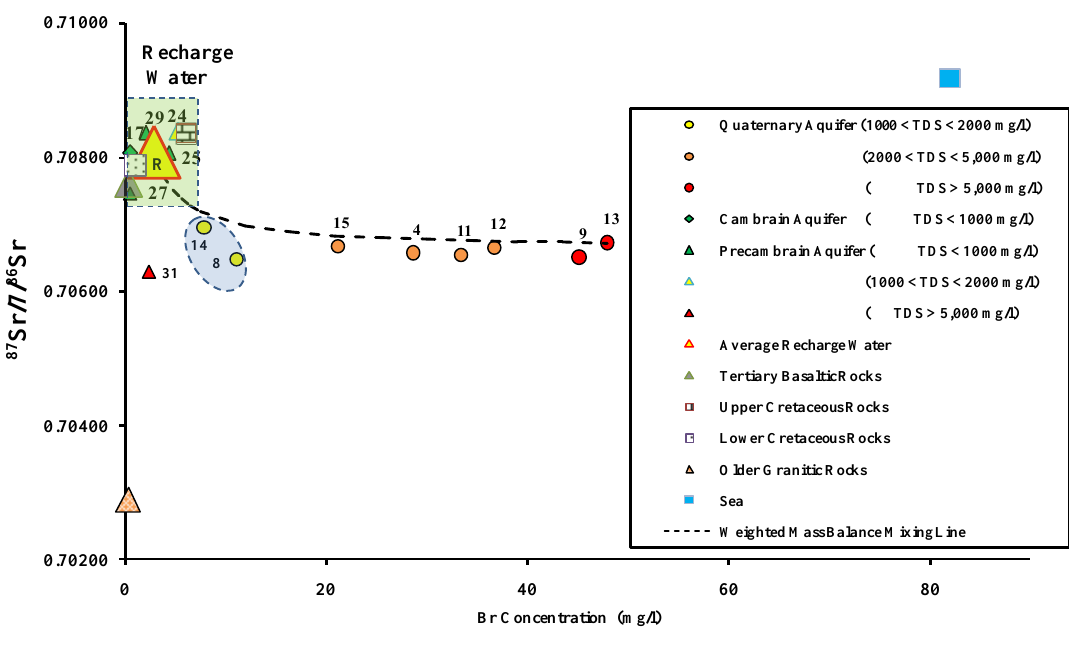
Table 2. Mineral Saturation indices for phases in NETPATH geochemical models. Positive values indicate over saturation; negative values indicate under saturation.